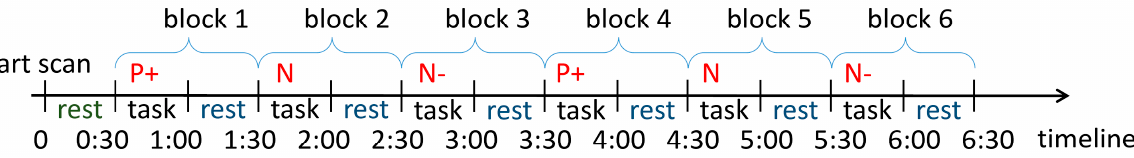
Figure 1. The fMRI paradigm design. The first rest period (indicated in green) was discarded to ensure reaching the T1 equilibrium. Six consecutive blocks were analysed. P+, demonstration of positive, happy faces; N, a task with neutral emotionless faces; N ‐ , a task with negative, sad